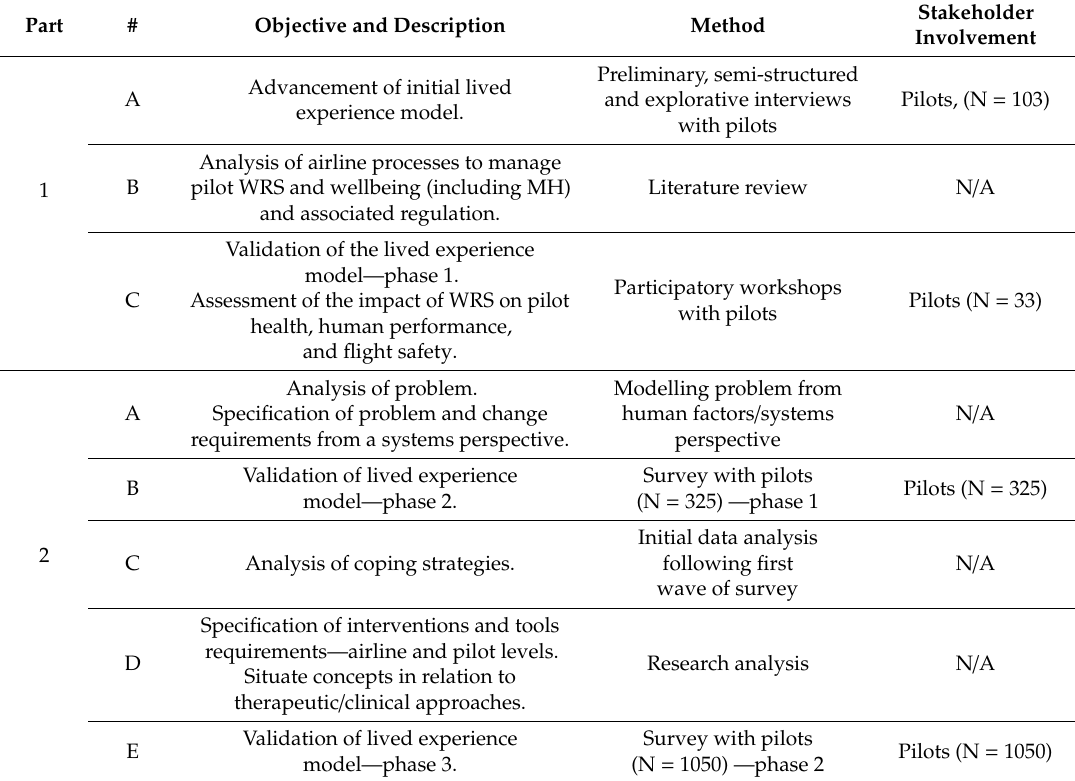
Table 1. Research parts and